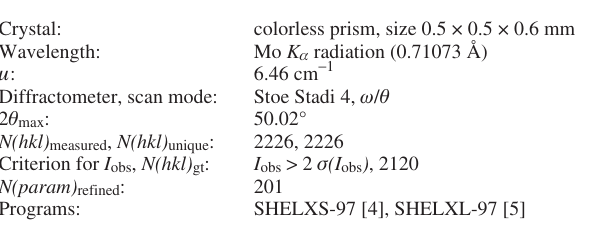
Table 1. Data collection and handling.